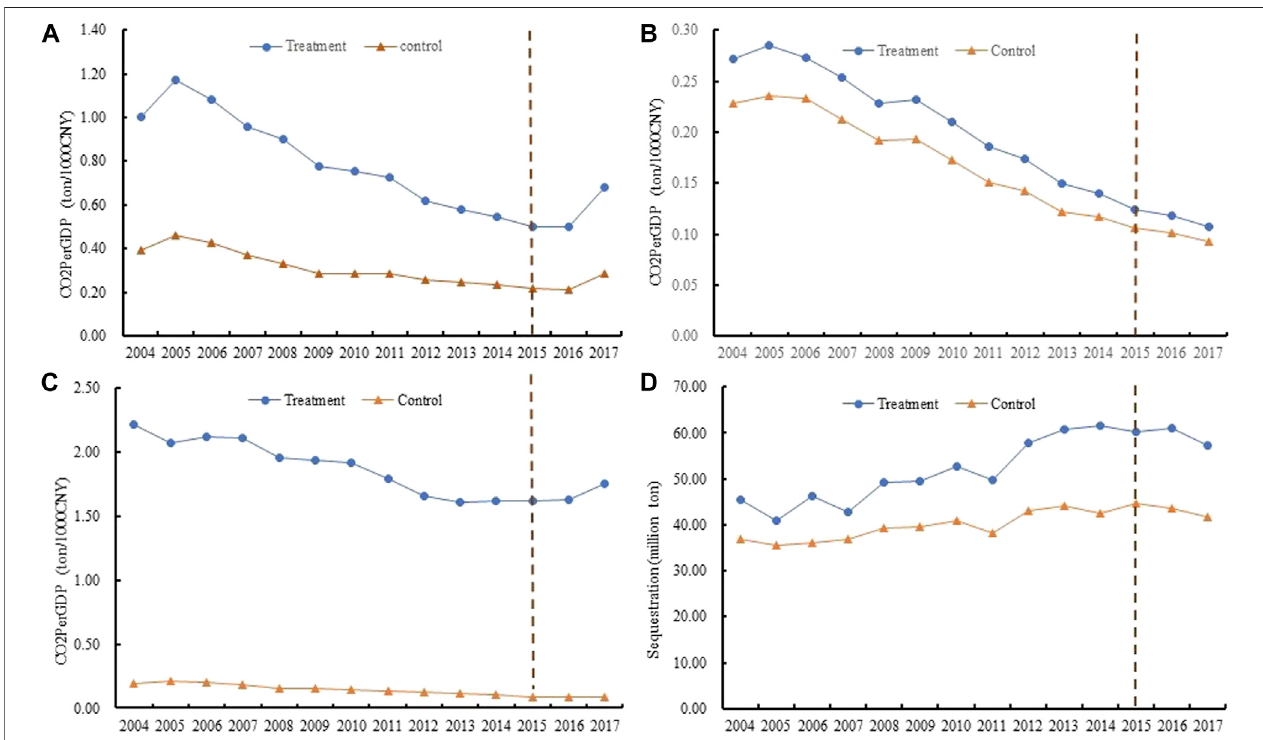
FIGURE 3 | Trends of average values of explained variables of the pilot and non-pilot cities over 2004 – 2017. Note: (A) , (B) , and (C) are the results of CO2PerGDP for Hulun Buir, Huzhou and Loudi cities, respectively. (D) displays the trend of Sequestration for Yan ’ an